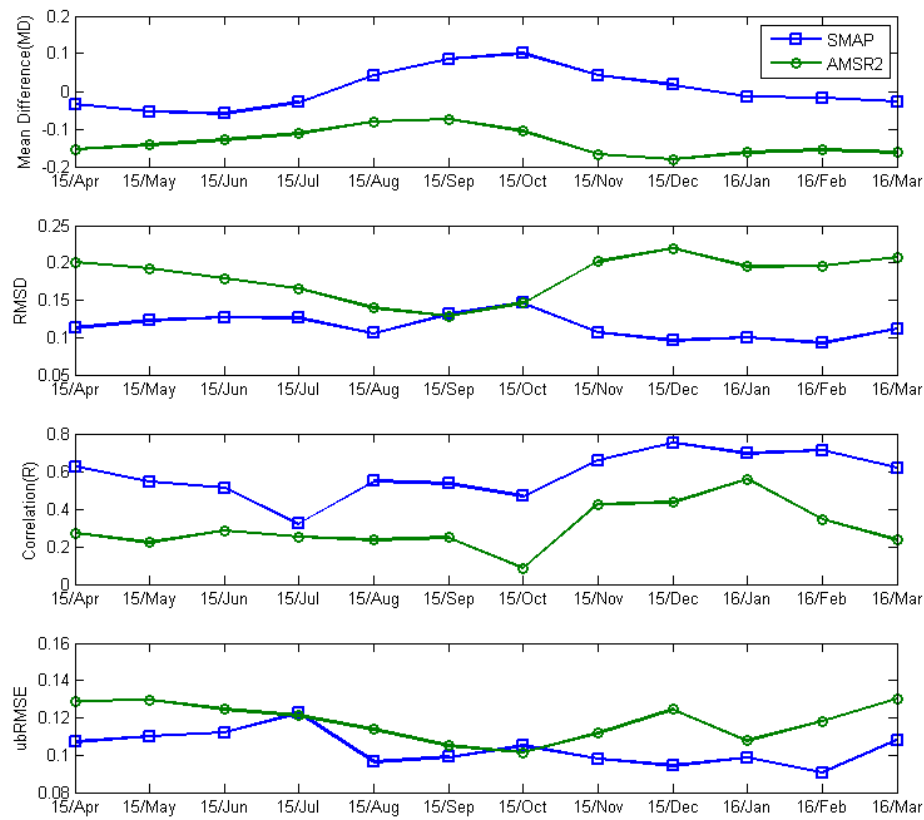
Figure 2. Temporal evolution of four statistics results for Soil Moisture Active/Passive (SMAP) L4 SM and Advanced Microwave Scanning Radiometer (AMSR2) L3 SM monthly data.